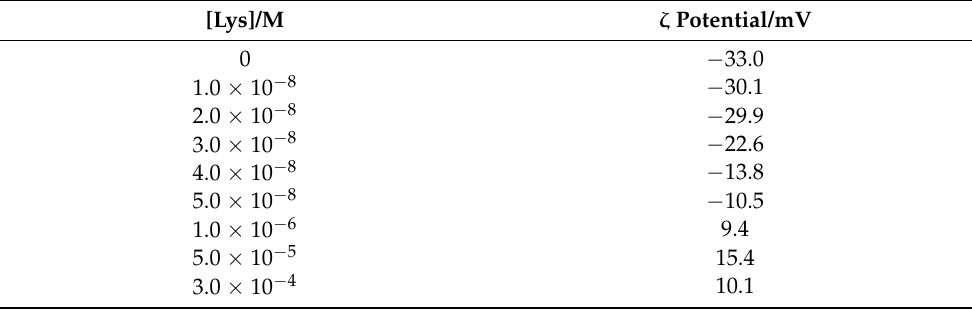
Table 2. Values of ζ potential/mV at different protein concentrations. [AuNPs (10 nm)]